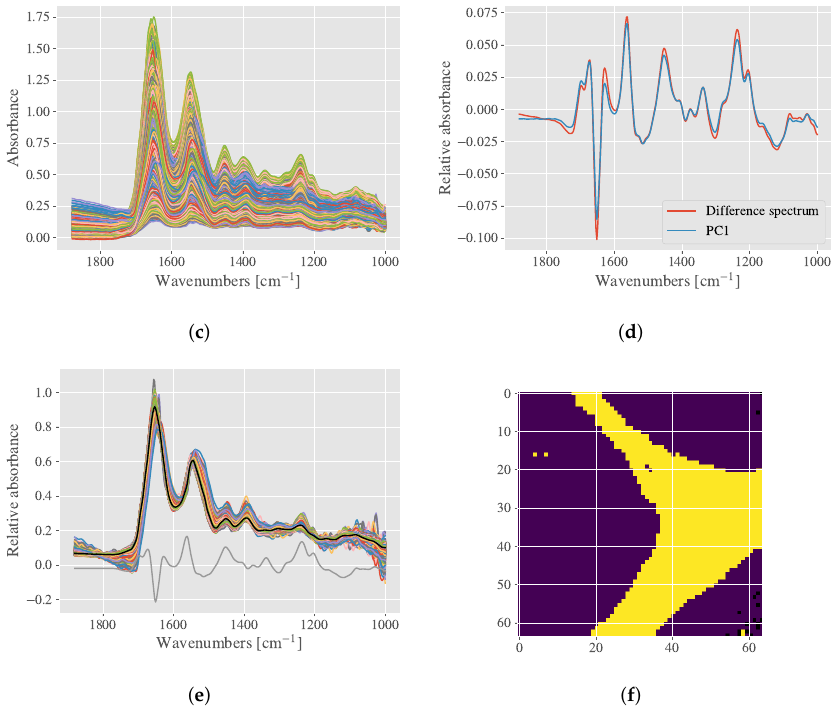
Figure 6. ( a ) Infrared image of beef loin tissue section, at 1653 cm − 1 . ( b ) Optical microscopy image of the same tissue section. ( c ) Raw spectra from the infrared image. ( d ) Difference spectrum shown in red (difference between mean of myofiber and connective tissue spectra) together with the first principal component from the PCA on the residuals in blue. The principal component is scaled to show that it contains almost exactly the same information as the difference spectrum. ( e ) Corrected spectra shown together with the mean spectrum (black), which is used as a reference in the EMSC, and the first principal component (gray) used as analyte spectrum. ( f ) Mask based on the analyte spectrum parameter. Yellow pixels refer to connective tissue, and blue to